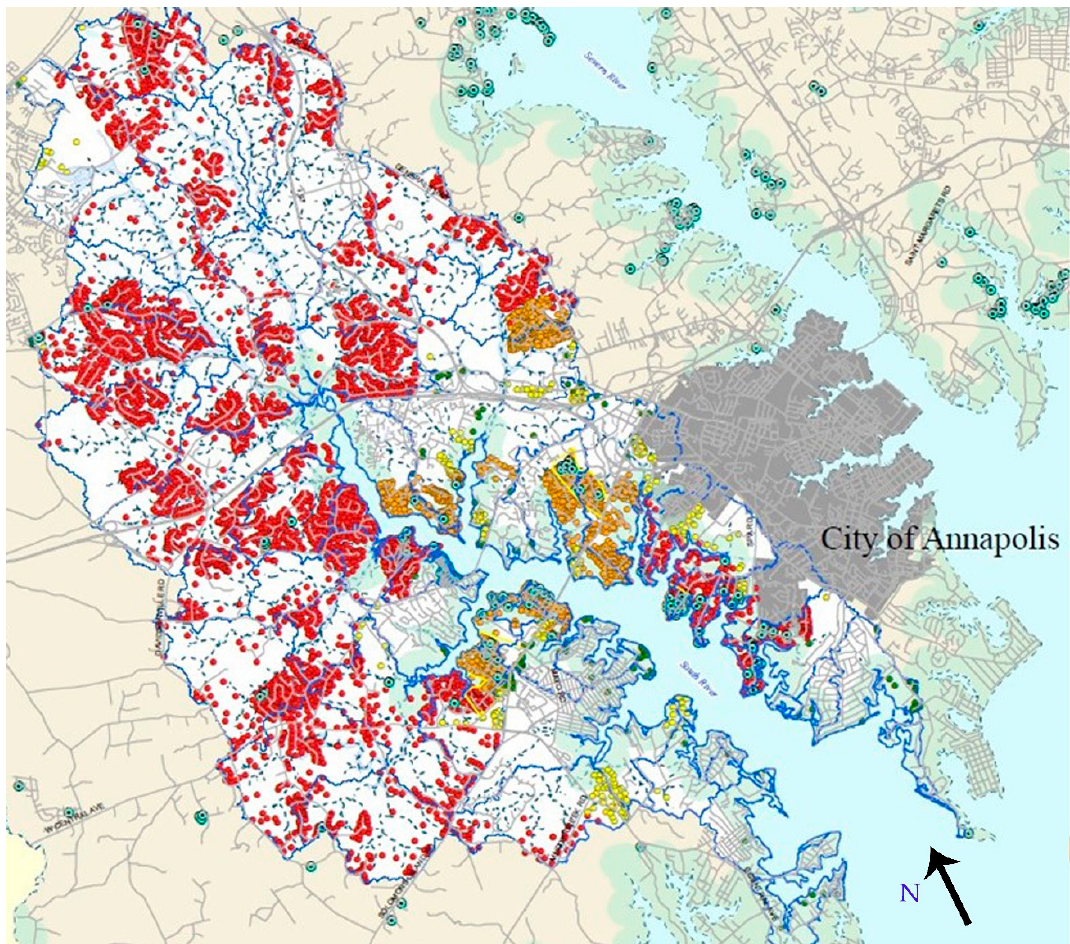
Figure 16. Red clusters indicate the Septic systems in this for the South River, MD. Watershed (https://www.aacounty.org/departments/public-works/engineering/forms-and-publications/, accessed on 1 December 2021) [73].